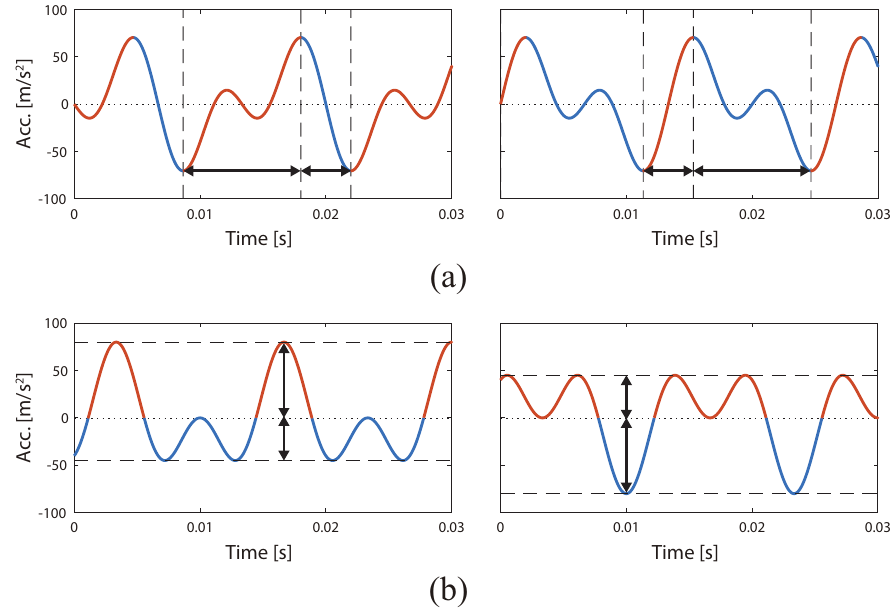
Figure 1. Examples of asymmetric vibration waveforms. ( a ) The waveform is asymmetrical along the time axis because the vibration profiles of the rising and falling accelerations differ with respect to each other. ( b ) The waveform is asymmetric along the amplitude direction because the positive and negative vibration profiles differ with respect to each